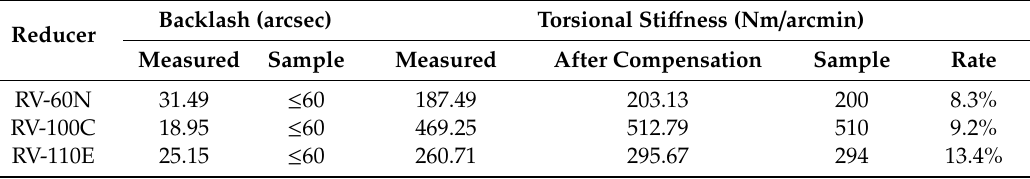
Figure 9. The measurement hysteresis curve of RV-100C. Table 5. Comparison of measurement results with sample data.